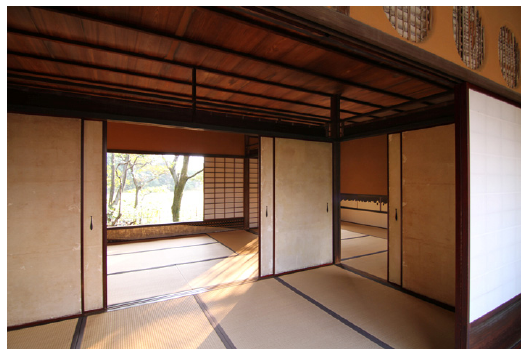
Figure 3. Open spatiality of Japanese house (Photo: Author).